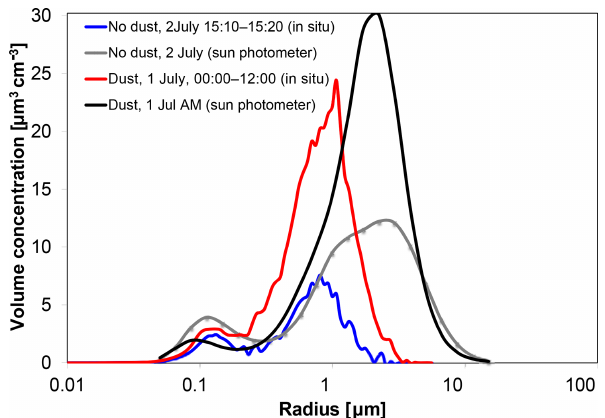
Figure 8. Volume particle size distributions for 1 July 2013 (dust case) and 2 July 2013 (no-dust case) measured in situ and by the inversion of the sun photometer data. The latter have been converted to the concentration using a layer height derived from the co-located lidar observations (see details in the